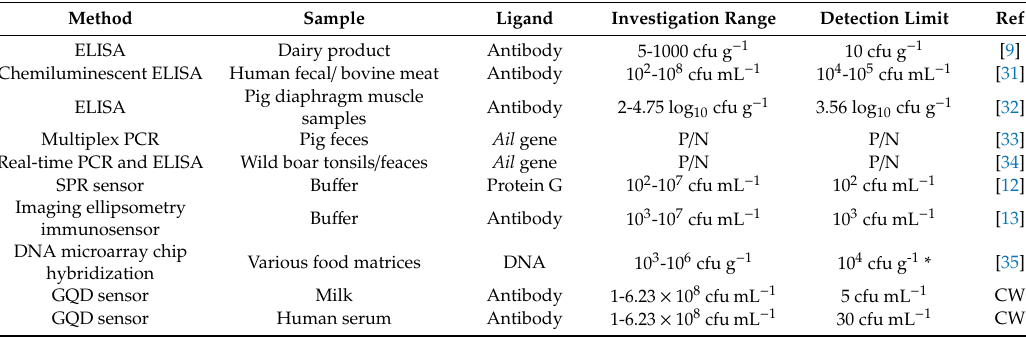
Table 1. Comparison of various techniques for the detection of Y. enterecolitica . Method